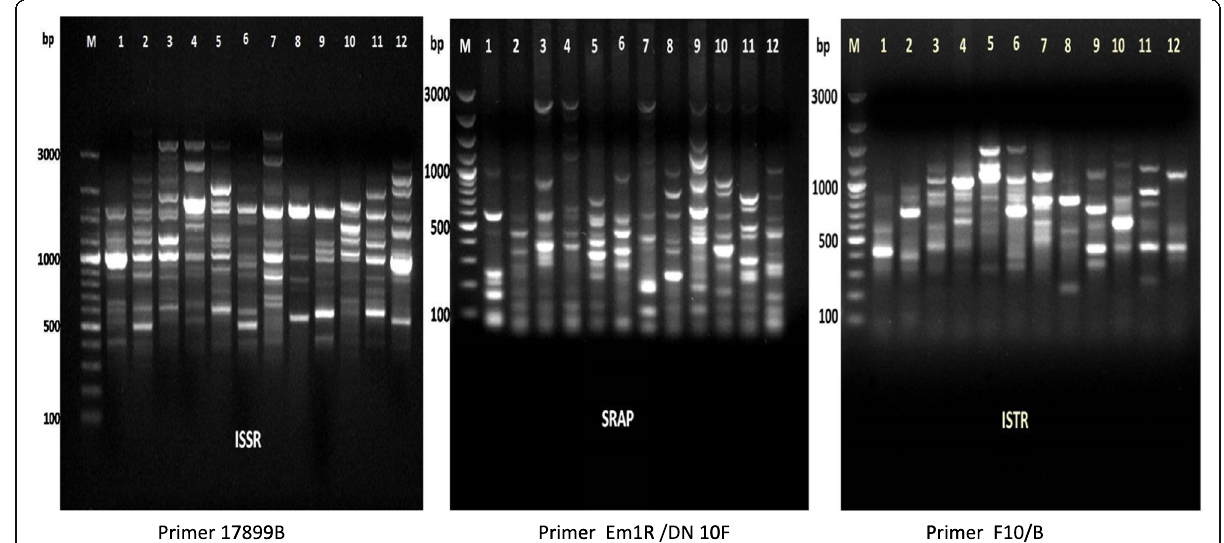
Fig. 4 Observed the ISSR ( a ), SRAP ( b ), and ISTR ( c ) profiles of 12 Capparaceae